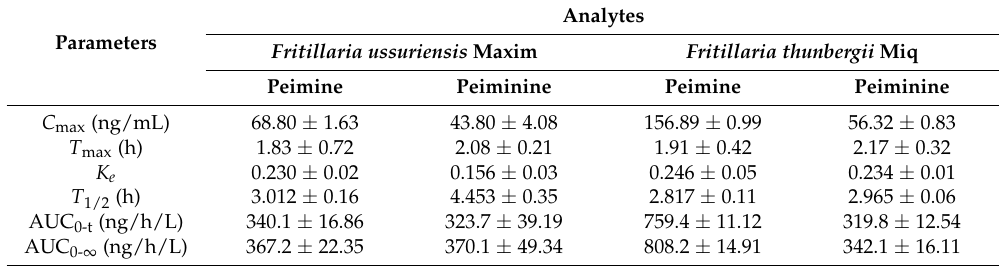
Table 6. Pharmacokinetic parameters of two constituents after oral administration of FU and FT powder (mean ± SD, n =